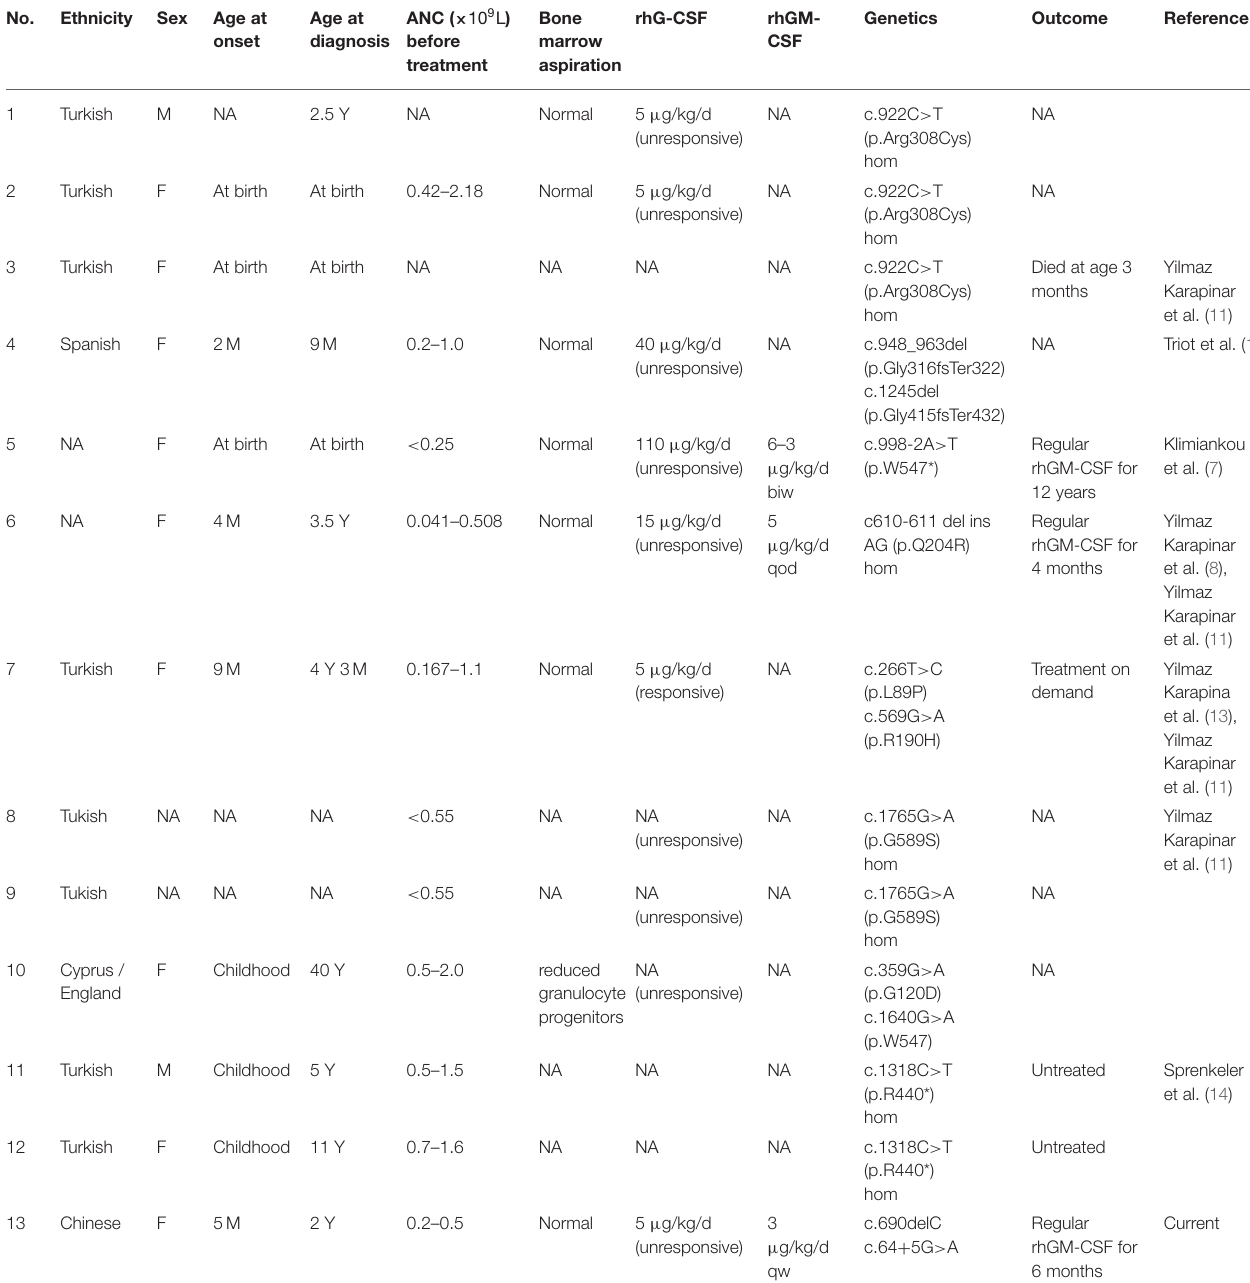
TABLE 2 | The clinical characteristics and treatment of children with congenital neutropenia caused by biallelic CSF3R mutations in the literature. No. Ethnicity Sex Age at